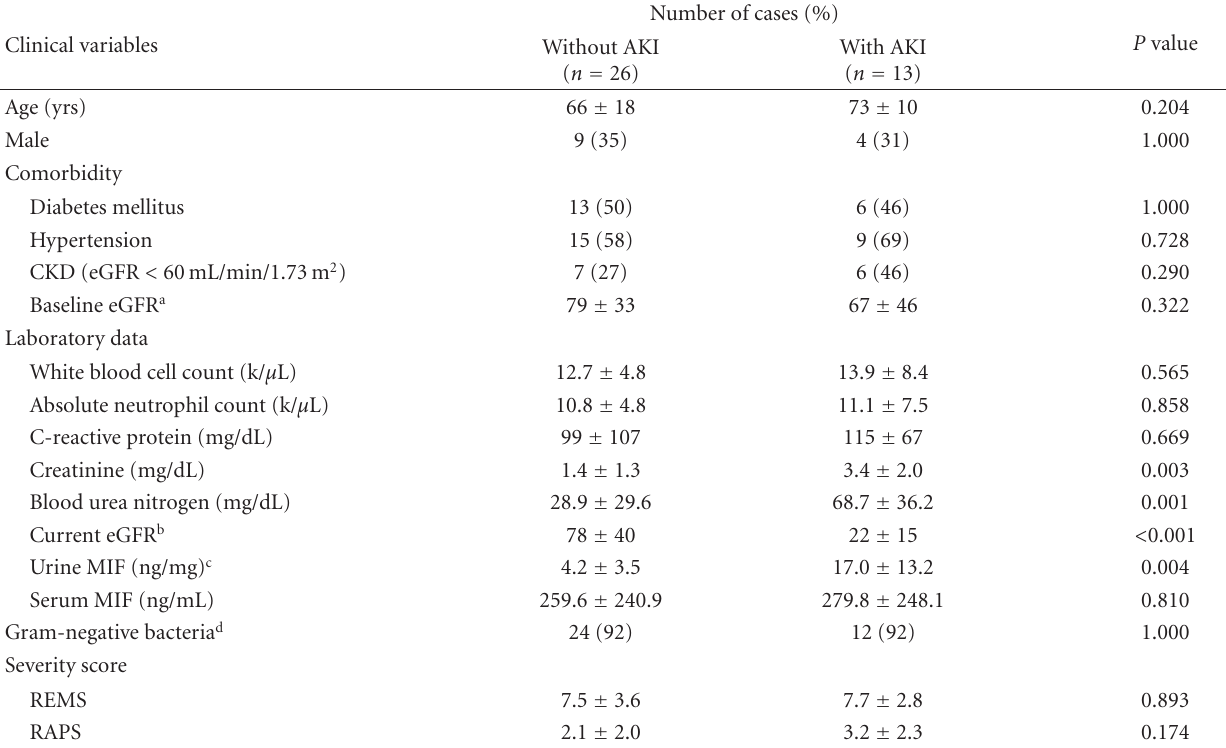
Table 1: Demographic data and clinical characteristics of patients with APN.